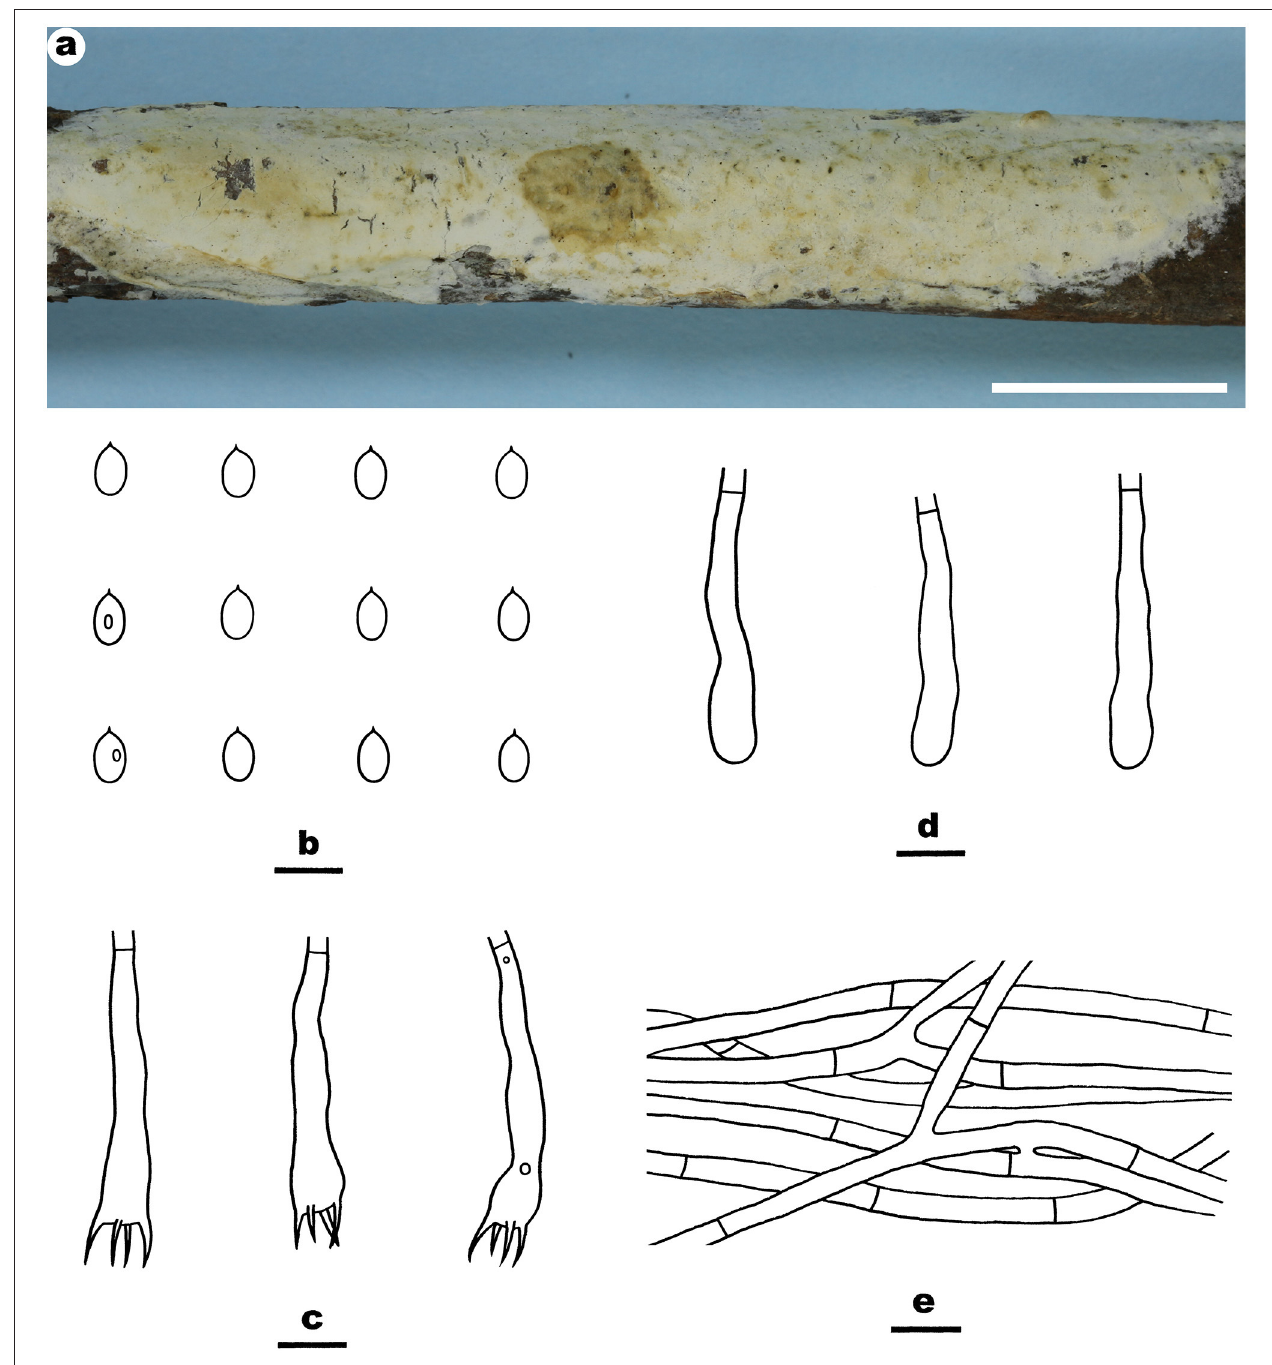
FIGURE 6 | Efibula taiwanensis (from the holotype He 4582a; scale bars: a = 1cm; b–e = 10 µ m). (A) Basidiomata. (B) Basidiospores. (C) Basidia. (D) Basidioles. (E) Hyphae from subiculum.